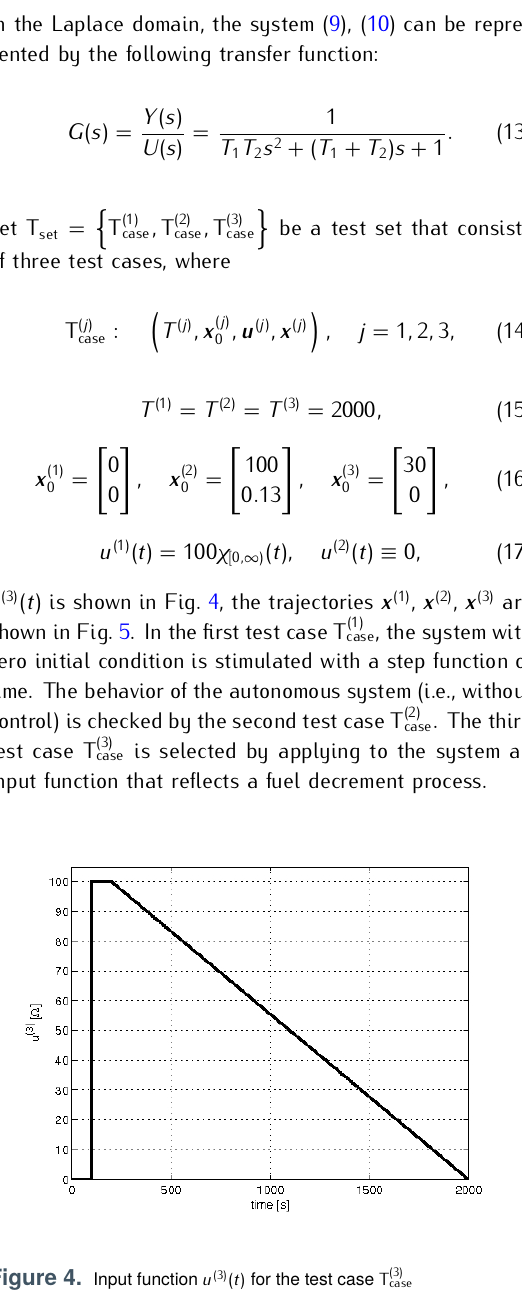
( t ) for the test case T (3)